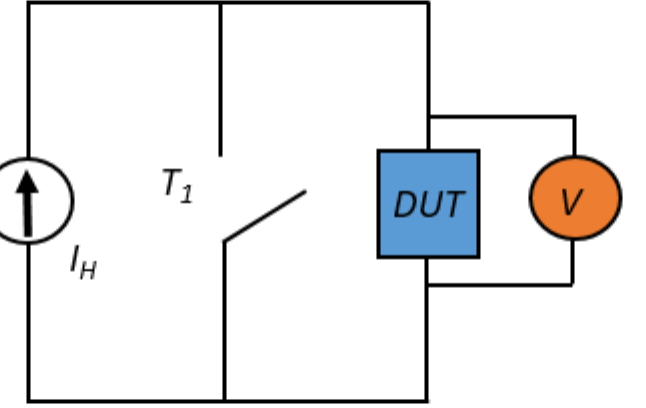
Figure 8. Electrical circuits of a DUT for the static measurement of the voltage under high